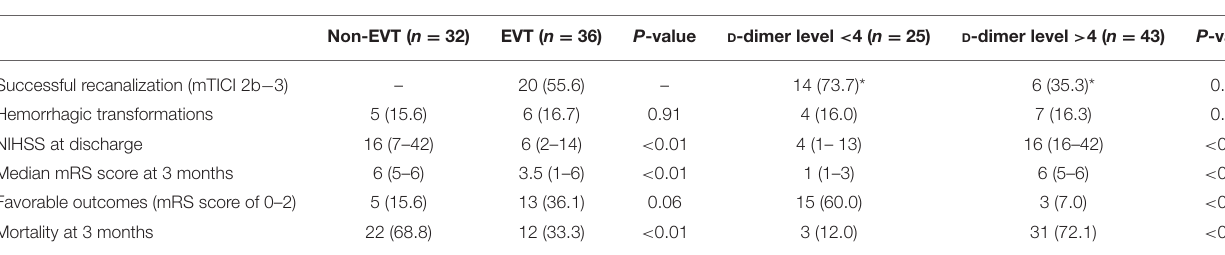
TABLE 2 | Clinical outcomes by EVT and D -dimer